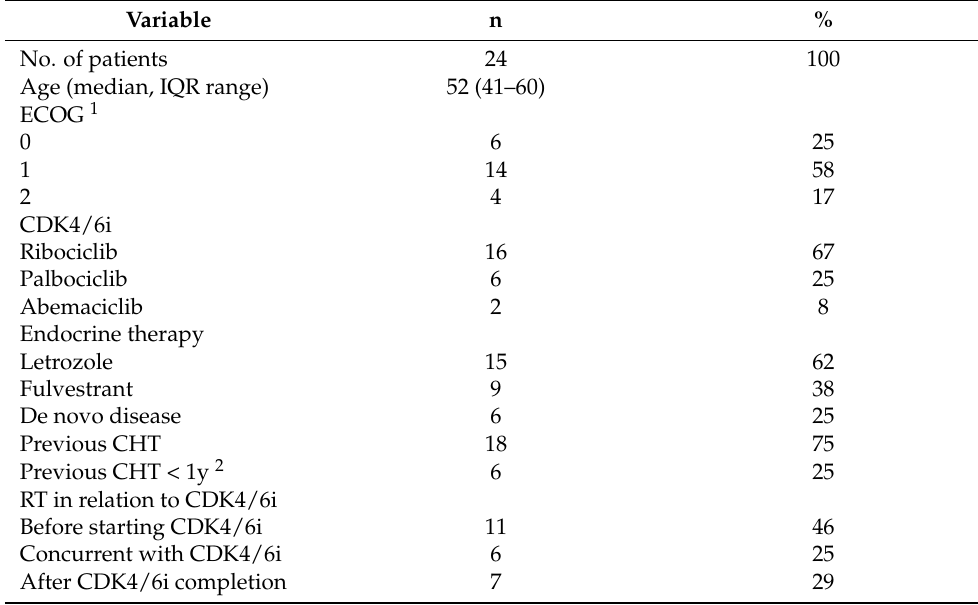
Table 1. Characteristics of the treated